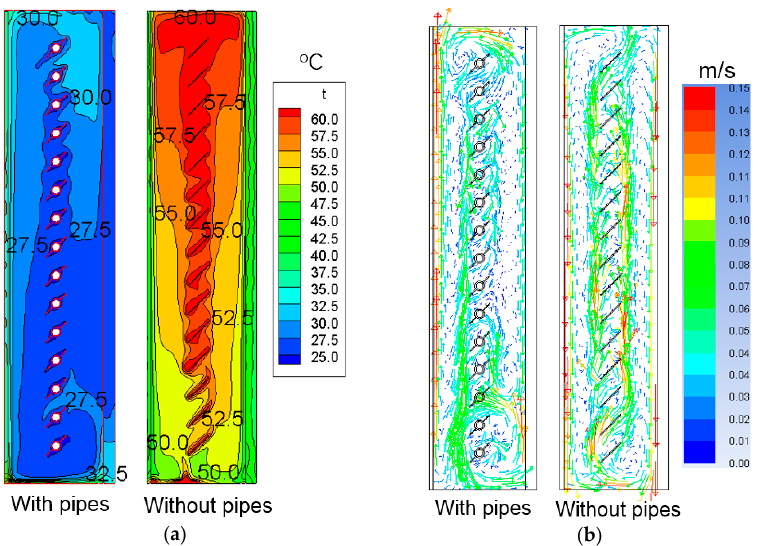
Figure 6. Cross section of the window: ( a ) Temperature distribution; and ( b ) Velocity distribution.